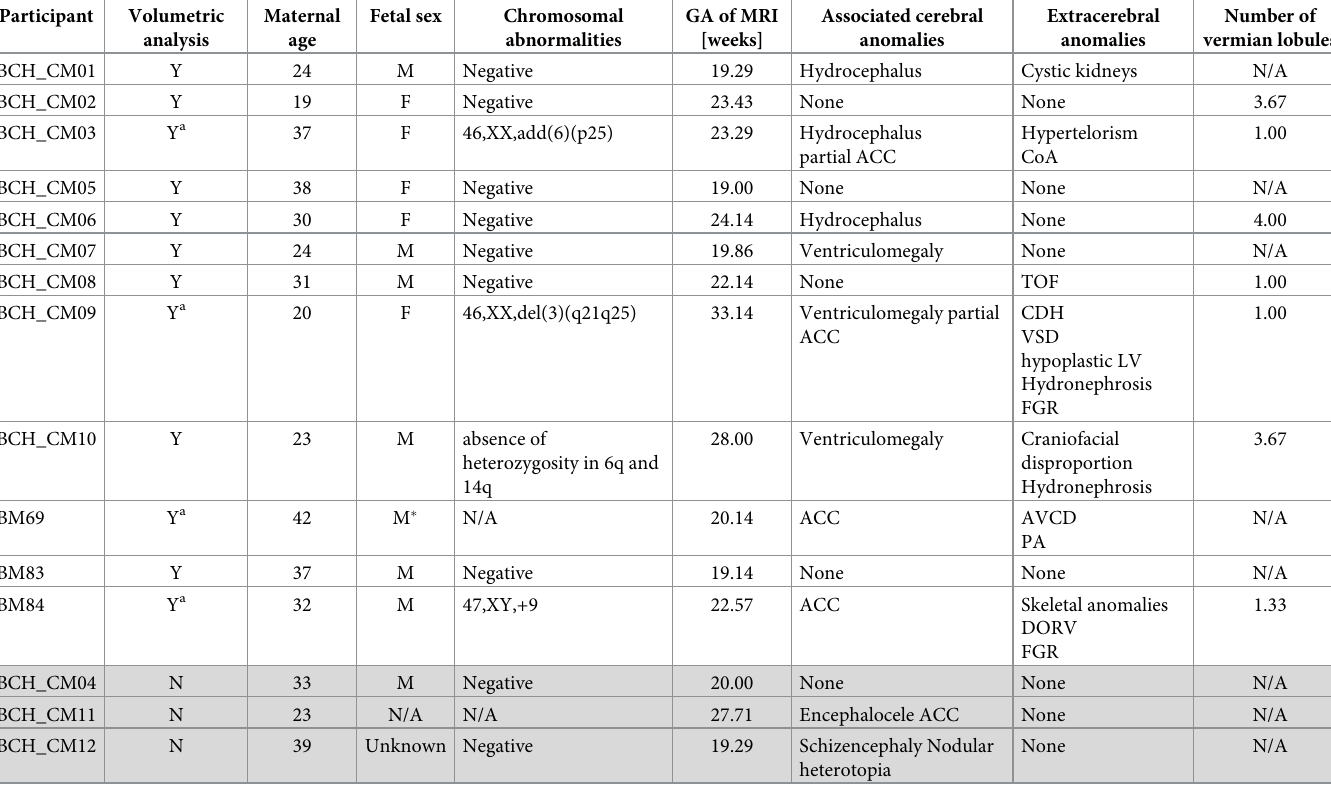
Table 1. Demographics of fetuses with Dandy-Walker malformation.